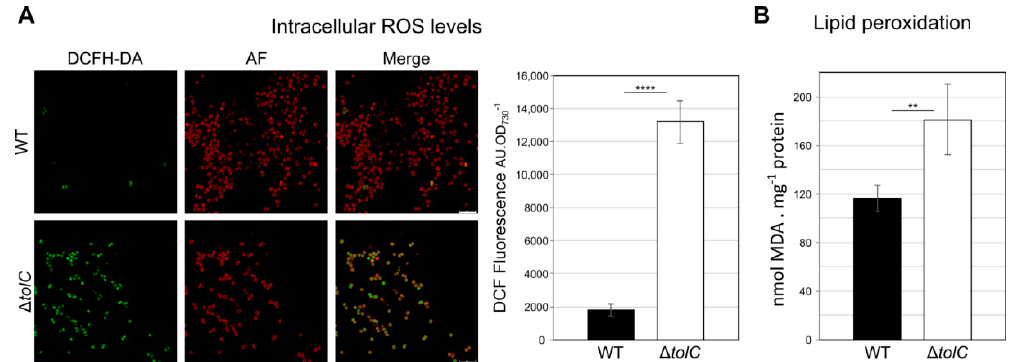
Figure 5. Synechocystis sp. PCC 6803 ∆ tolC mutant cells present higher levels of intracellular reactive oxygen species (ROS) and lipid peroxidation than wild-type (WT) cells. ( A ) Both Synechocystis sp. PCC 6803 strains were incubated with the ROS detecting probe 2 ′ ,7 ′ -dichlorodihydrofluorescein